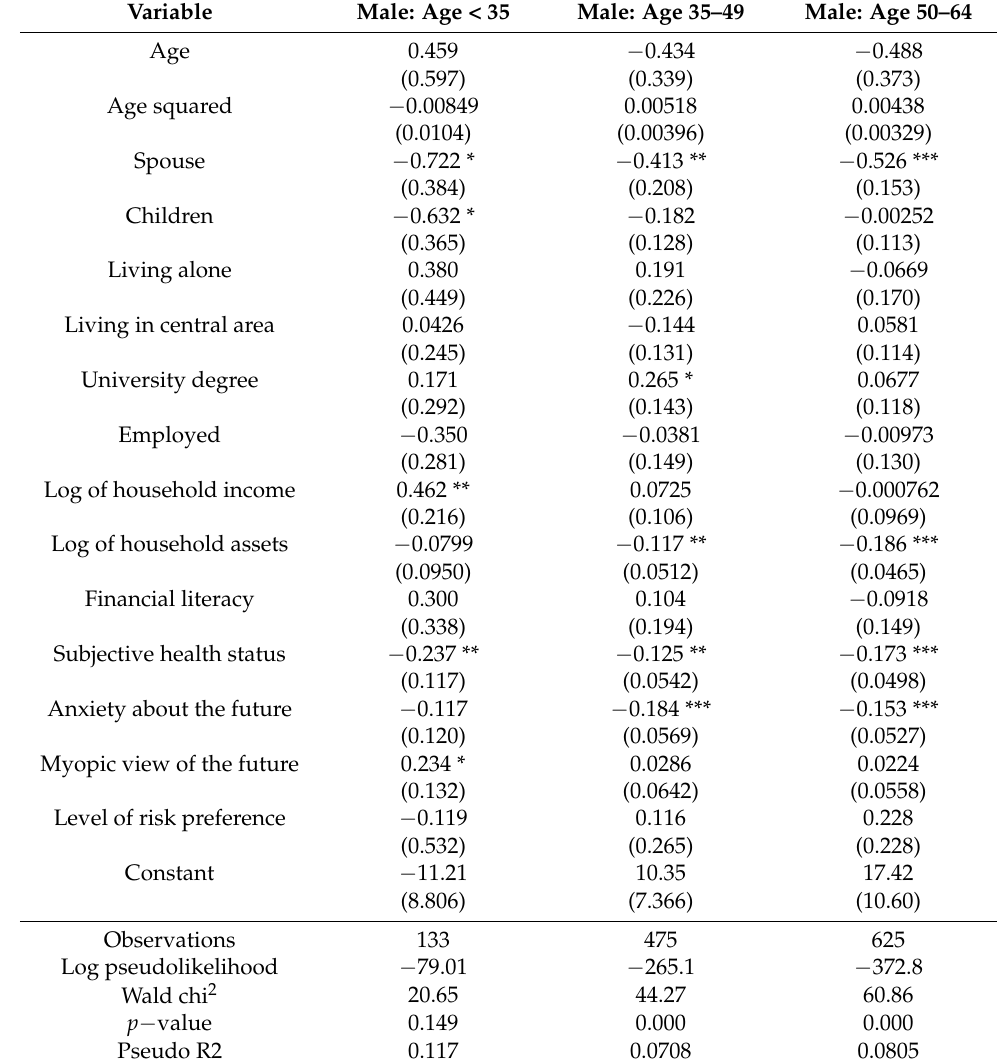
Table 7. Results of probit regression analysis regarding younger males’ reluctance to receive the third dose of COVID-19